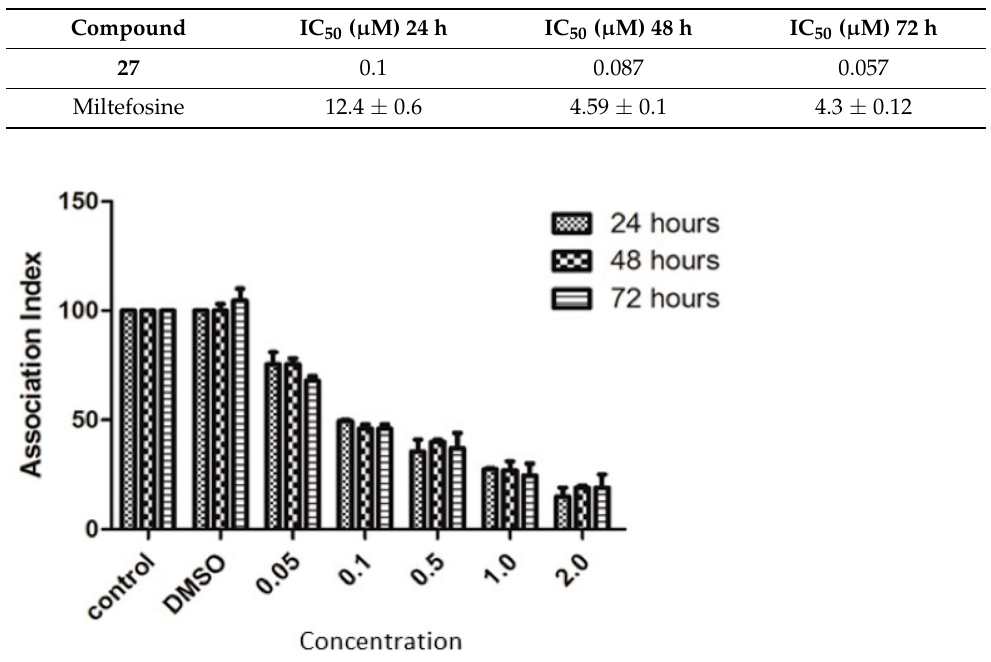
Figure 6. Evaluation of the cytotoxic effect on T. cruzi trypomastigotes with compound 27. The eval- uation was done after 24 h of treatment. Morphological analysis of epimastigotes and amastigotes treated with click phospholipid 27 : Since compound 27 was the most potent against all the developmental stages of T. cruzi , scanning and transmission electron microscopy were employed to analyse the effects on epimastigotes and intracellular amastigotes. Treatment of T. cruzi epimastigotes with 27 for 72 h (100 nM) resulted in changes in their morphology, gradually losing the typical elongated form and acquiring a rounded shape (Figure 7B,C), confirming initial observa- tions made by light microscopy (data not shown).